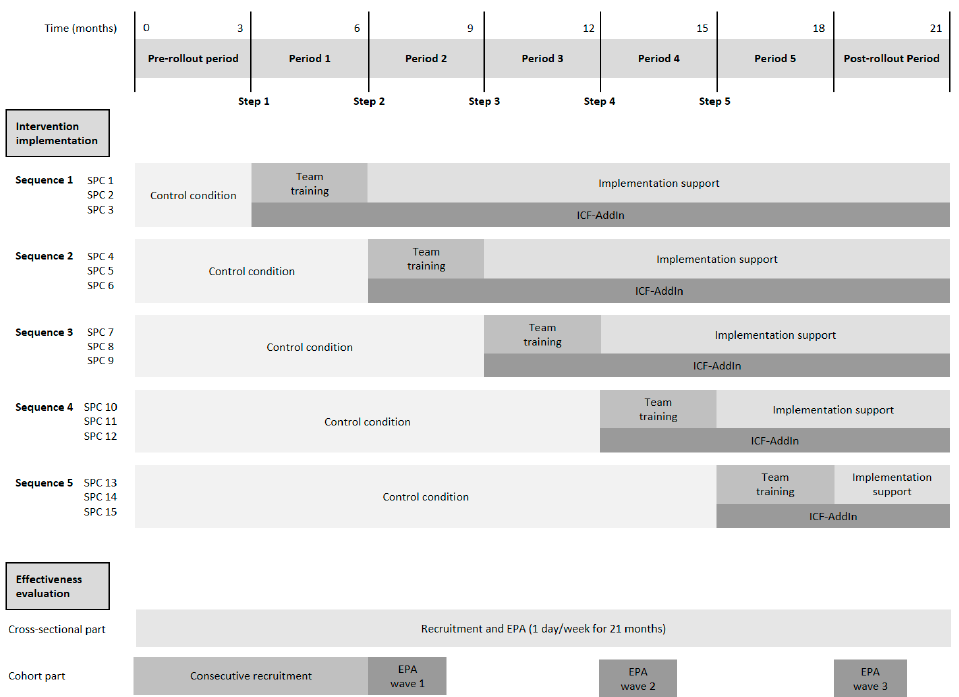
Figure 2. Design of the effectiveness evaluation. For SPC 13–15 the implementation support is continued beyond the end of the effectiveness evaluation (not shown in the figure). EPA, endpoint assessment; SPC, social paediatric